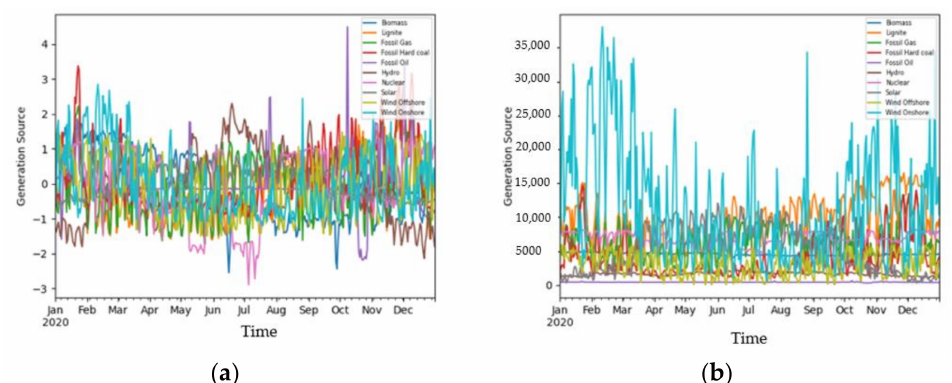
Figure 3. This figure represents the German electricity generation. ( a ) Shows an approach using data standardization which has been defined in Formula (3); ( b ) Shows the electricity generation sources in MWh. Figures 3–5 got generated using the same code in Python.